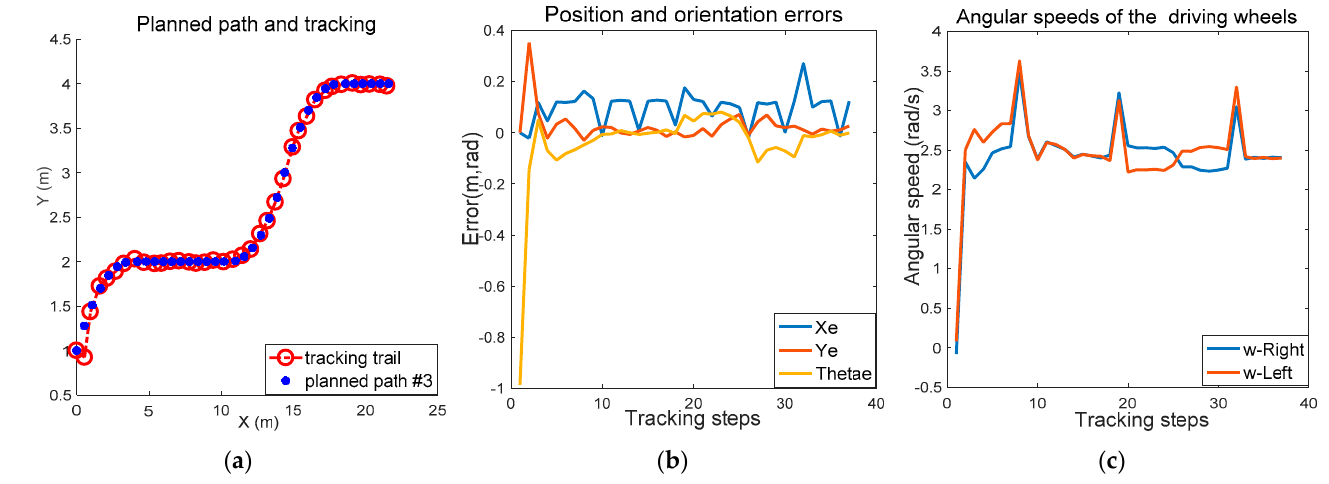
Figure 13. Path tracking combining state estimation and BP neural network: ( a ) the coincidence between expected and tracking paths; ( b ) the position and orientation errors; ( c ) the required angular speeds of the driving wheels.